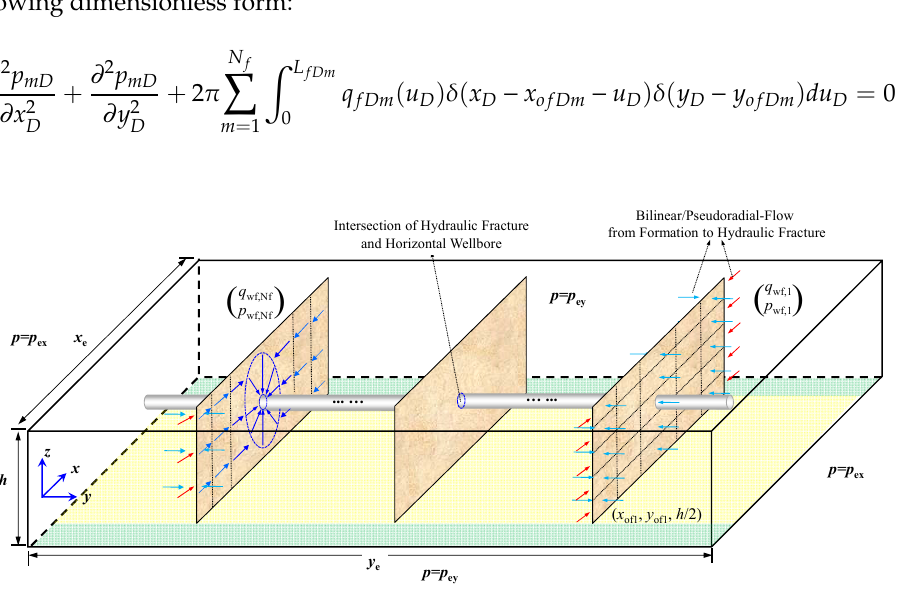
Figure 3. Schematic of MFHW in the inner region with constant-pressure outer boundary.